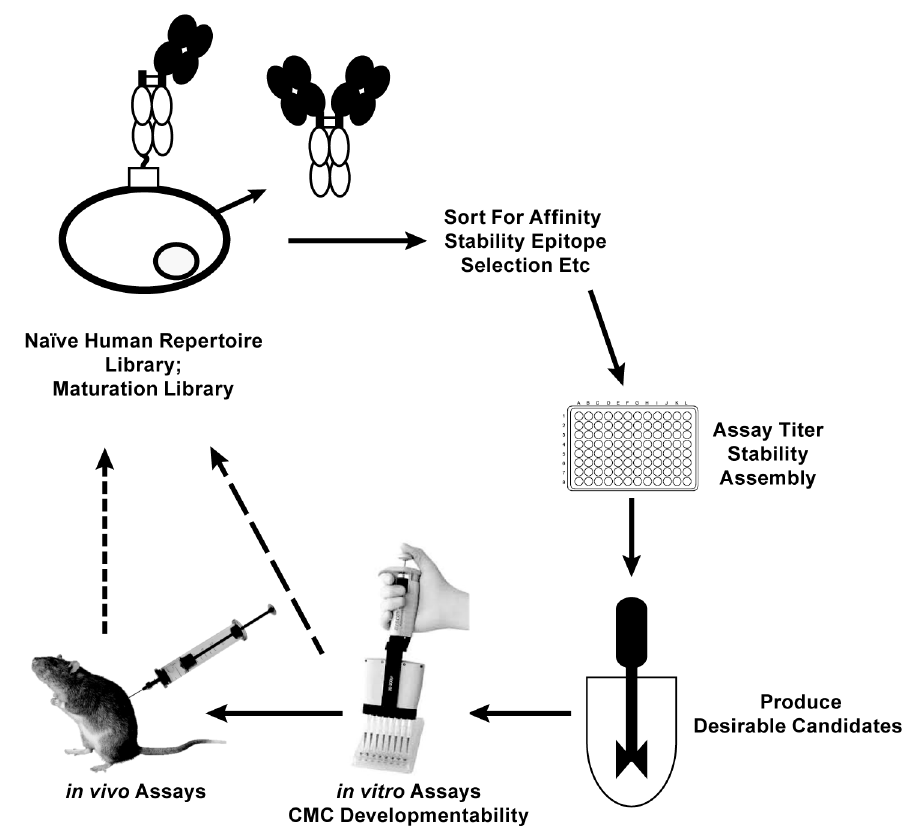
Figure 5. An antibody discovery and optimization scheme that utilizes Fc-Sed11p display-secretion technology in humanized Pichia pastoris . This paradigm enables progression from lead discovery to preclinical validation and development using a single